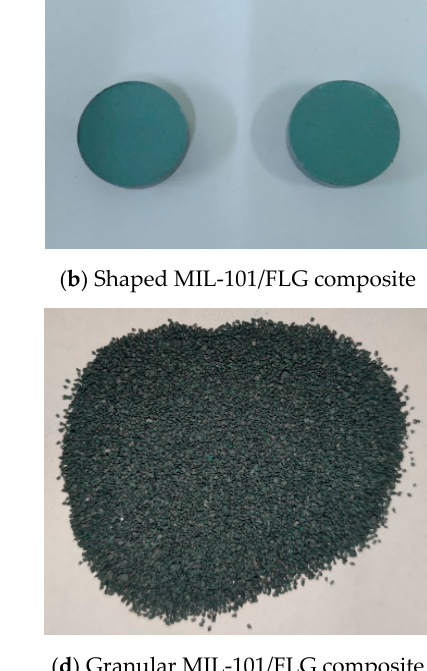
Figure 1. Exterior morphology of shaped and granular MIL-101 and MIL-101/FLG composite. ( a ) Shaped MIL-101. ( b ) Shaped MIL-101/FLG composite. ( c ) Granular MIL-101. ( d ) Granular MIL-101/FLG composite.